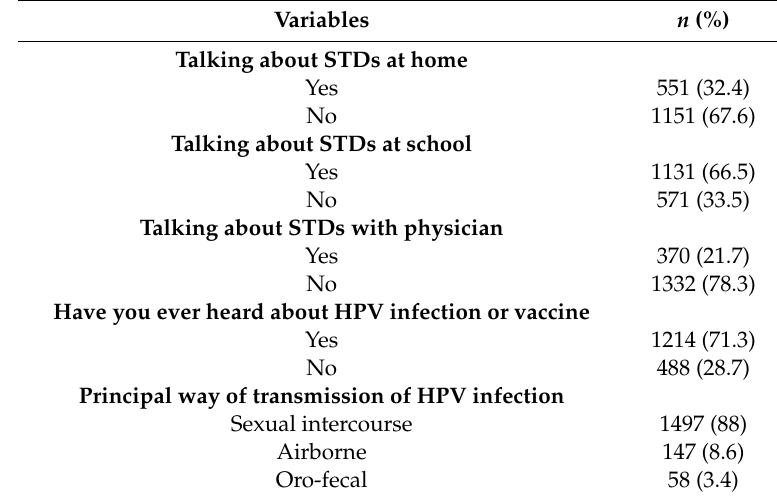
Table 2. Attitudes and knowledge of students enrolled in the study, regarding sexually transmitted diseases (STDs) and Human Papilloma Virus (HPV) vaccination, in the pre-intervention questionnaire ( n =